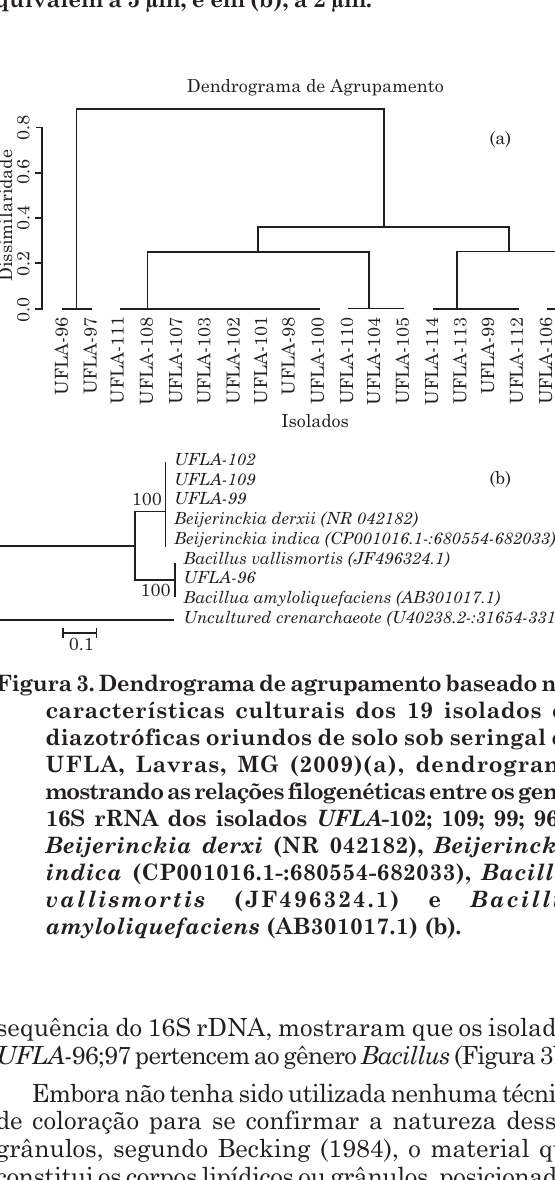
1. (a) e (b): Formato celular de bastonete apresentado por 17 dos isolados encontrados no solo sob seringal. Em (b), as setas indicam os glóbulos de PHB; (c): isolado UFLA -96, a seta evidencia endósporos centralmente localizados. Em (a) e (c), as barras equivalem a 5 µm, e em (b), a 2 µm.